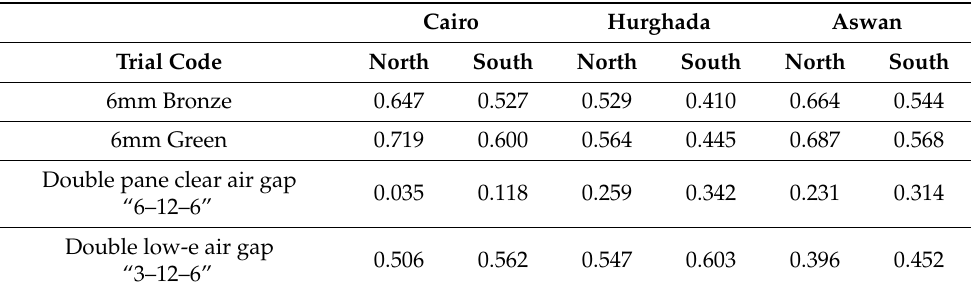
Table 8. The scores for all transparent alternatives in the energetic scenario.